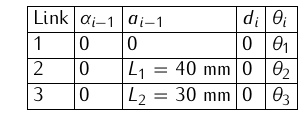
Table 5. Denavit-Hartenberg Parameters of the